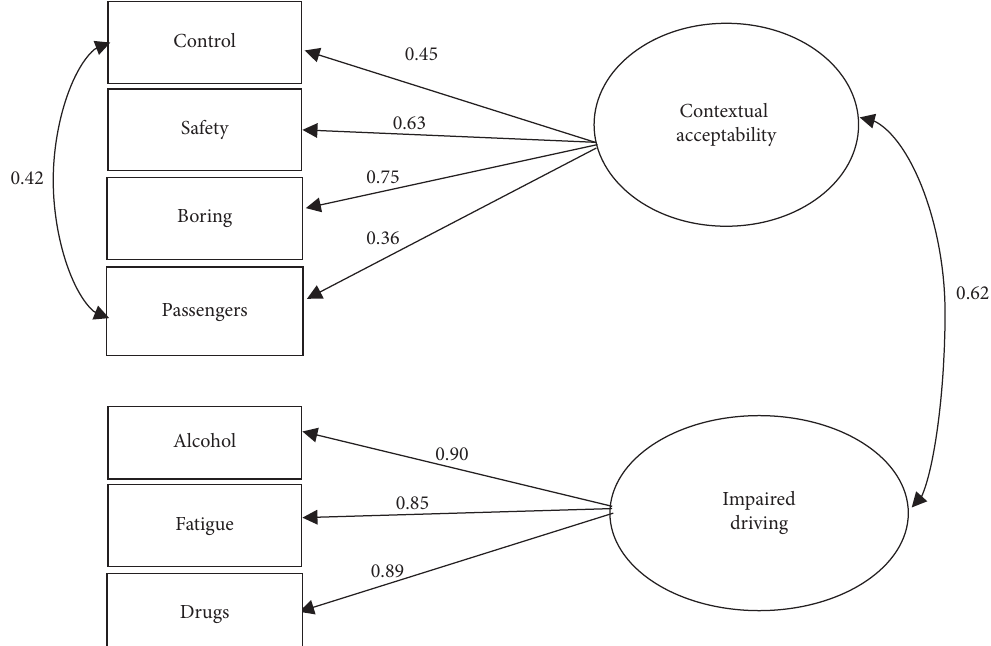
Figure 1: Results of the structural equation model on the AVAS with significantly standardized regression